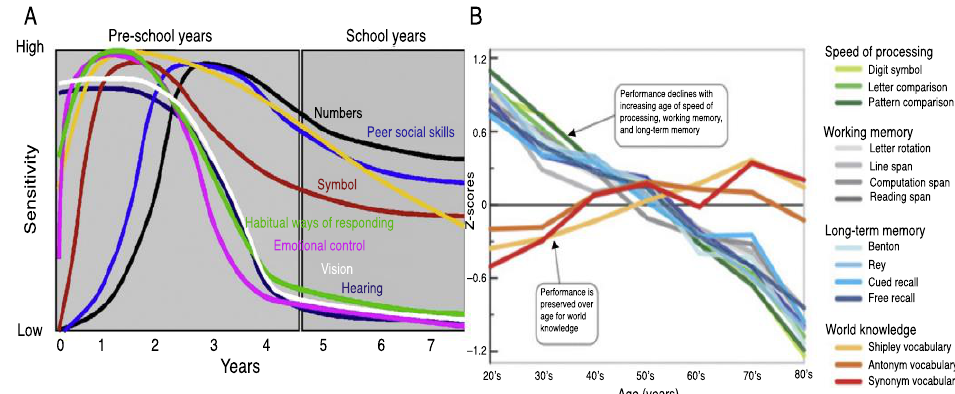
Figure 3. Sensitive periods during early brain development for ( A ) Sensation, emotional con- trol, numerosity and symbolic representation, working and long-term memory and vocabulary. ( B ) Processing speed, memory, and word as a function of age